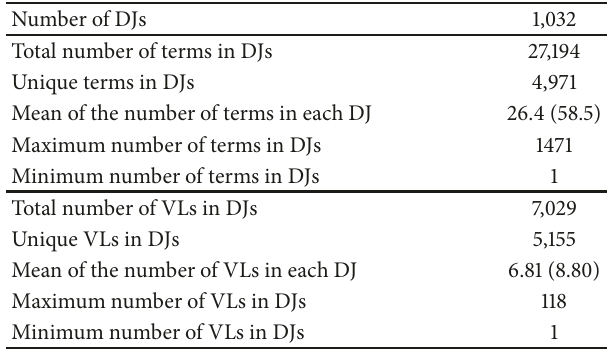
Table 4: Commonalities of terms and VLs using testdata atrandom (parentheses represent the standard